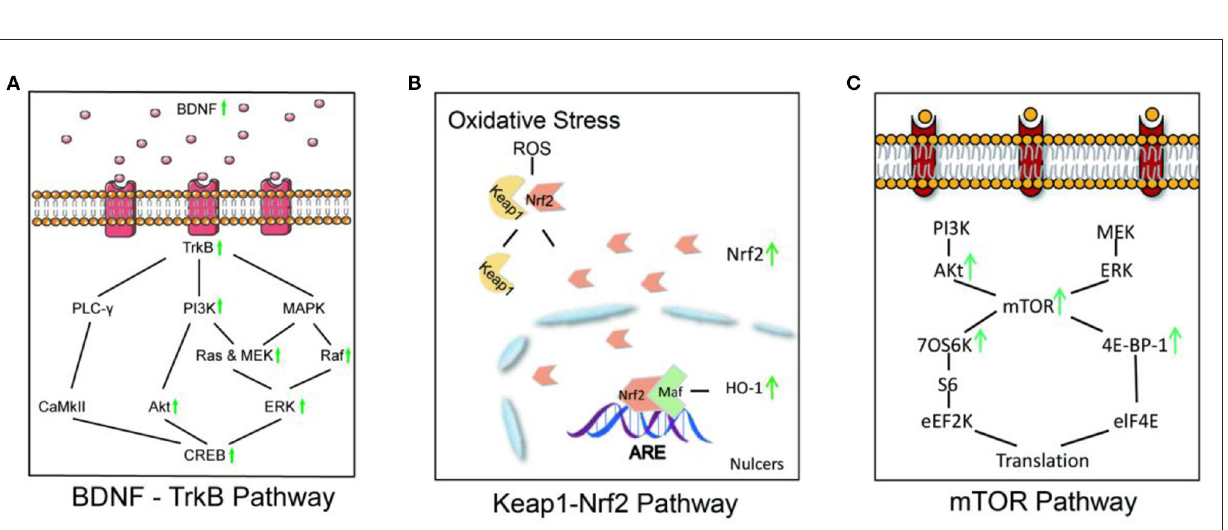
FIGURE4 Acupuncture affects signaling pathways in PTSD model animals. (A) In the BDNF-TrkB signaling pathway, acupuncture increases the phosphorylation of the key downstream enzymes PI3K, Akt, MEK, Raf, ERK, and CREB by upregulating the expression of BDNF and TrkB. (B) In the Keap1-Nrf2 signaling pathway, acupuncture increased the expression of Nrf2 and HO-1, which improved hippocampal neurogenesis and ameliorated anxiety-like behaviors in PTSD model animals. (C) In the mTOR pathway, acupuncture improved PTSD symptoms by increasing p-mTOR, as well as the upstream protein, p-Akt, the downstream proteins, p-70S6K and